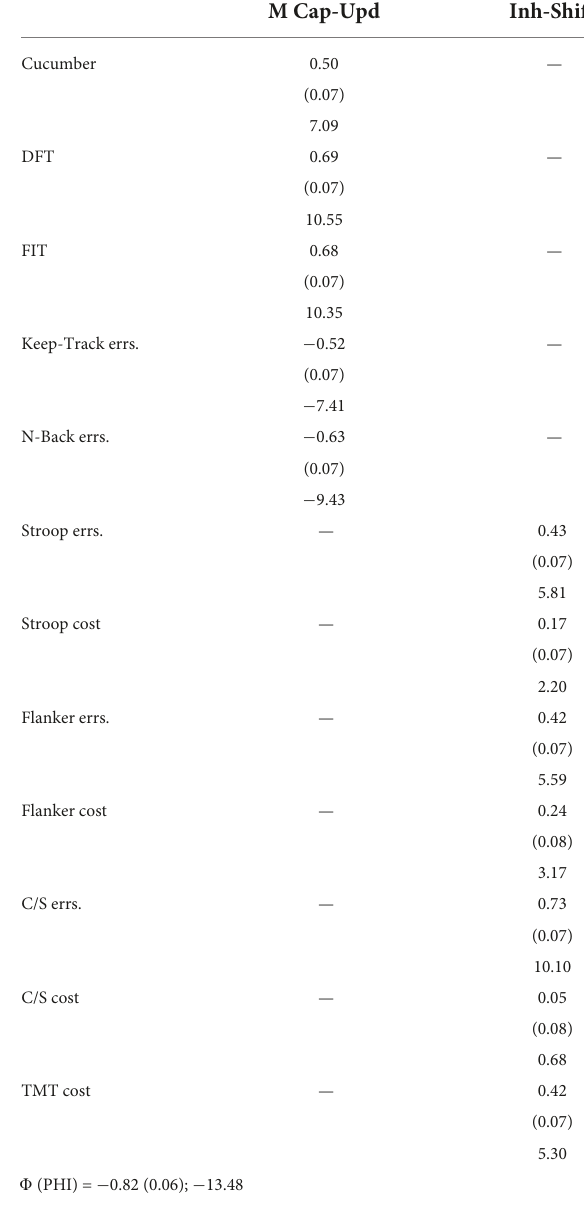
TABLE 1 Lambda-X matrix of the factor loadings for the two-factor model of general cognitive